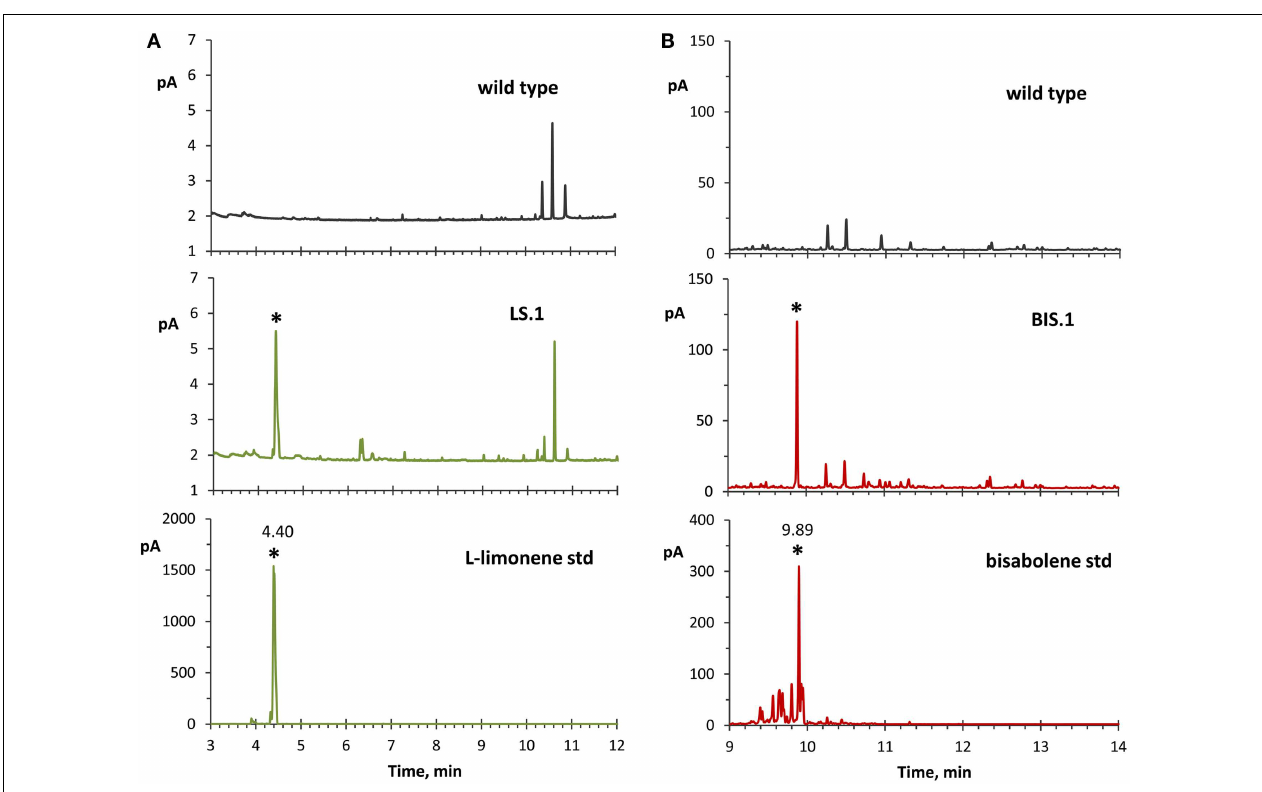
a peak with a similar retention time (9.89min) to a bisabolene standard, which is absent in the wild type. For these experiments, dodecane was used for bisabolene extraction because of the extended period of time required to accumulate detectable levels of bisabolene, whereas hexane was applied for better limonene peak resolution due to the reverse solvent effect observed with